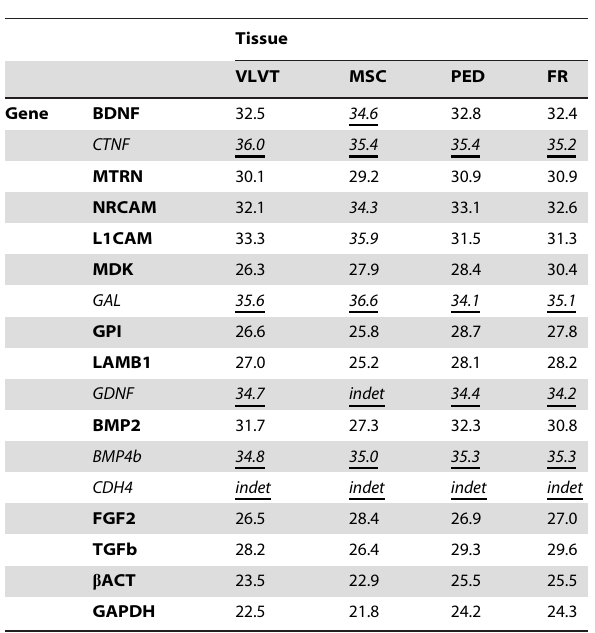
The table details the average cycle threshold (Ct) for each tissue and gene analyzed. Ct values in italics underline type corresponded to genes considered not expressed for a given group of samples. This category includes all genes with Ct values over 35 (upper limit of detection) and those with undeterminable Ct values. GDNF was considered unexpressed in all tissues because the PCR system flagged all its measurements in spite that the CT values were just below 35. VLVT corresponds to velvet, MSC to mesenchyme, PED to pedicle skin, and FR to frontal skin.